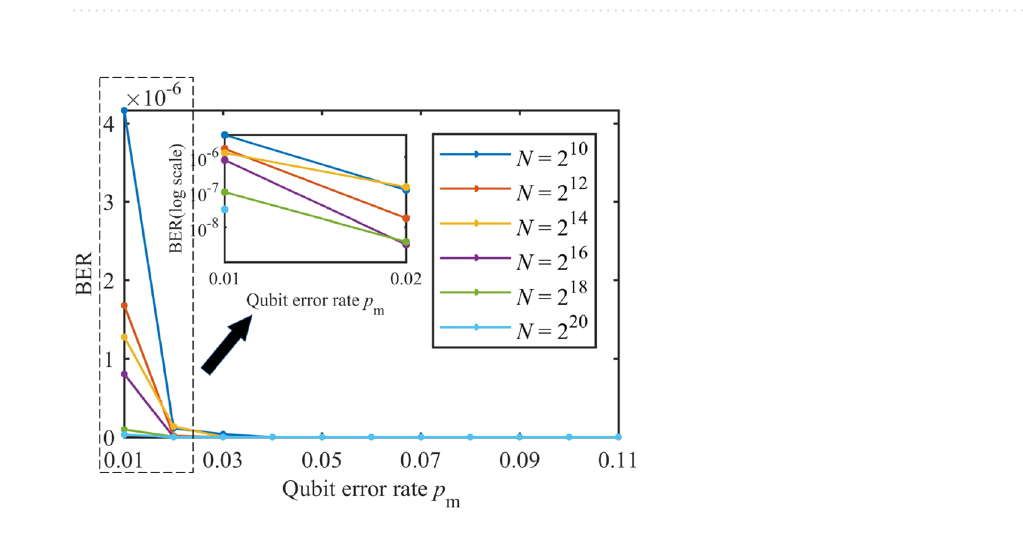
Figure 10. The decoding BER of